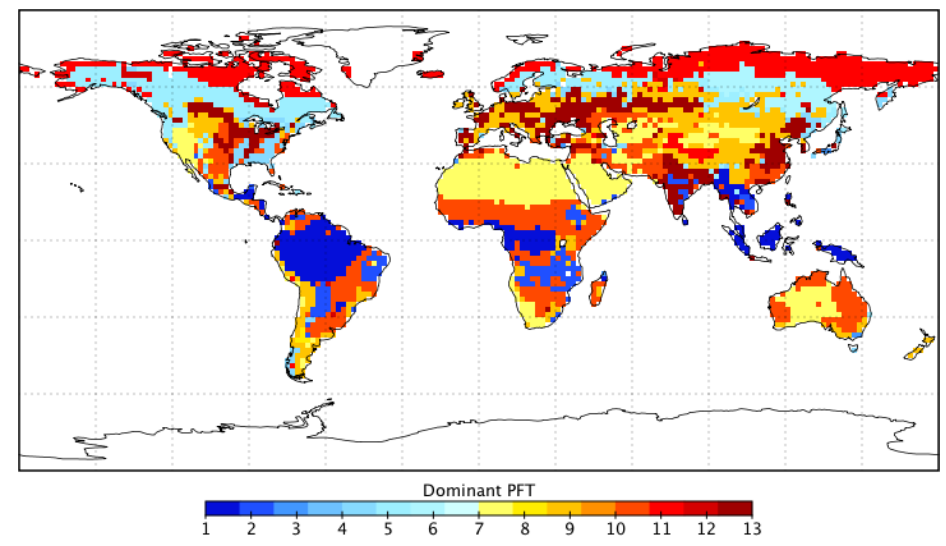
Figure A1. Spatially dominant PFT for each BETHY-SCOPE model grid cell.